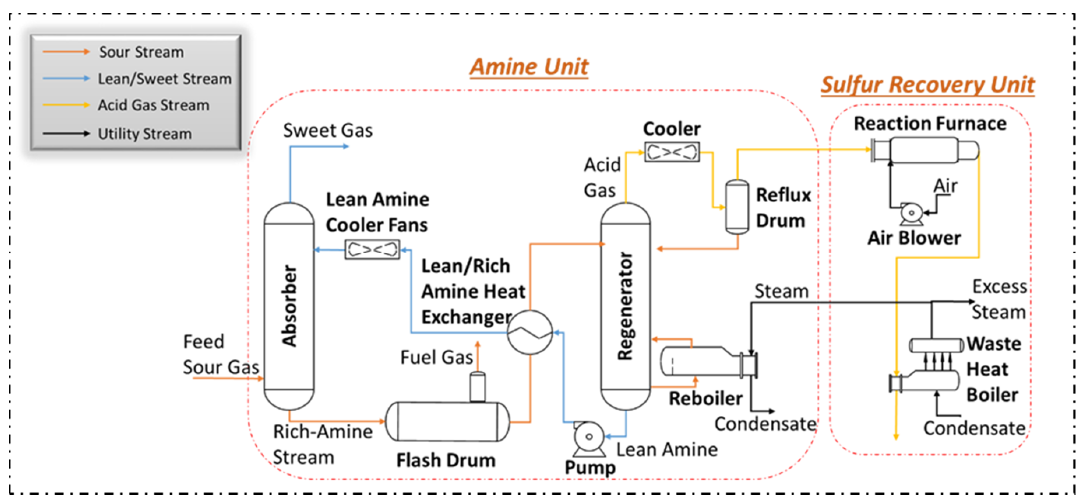
Figure 1. Simplified process flow diagram of the amine stand-alone process showing major equipment.